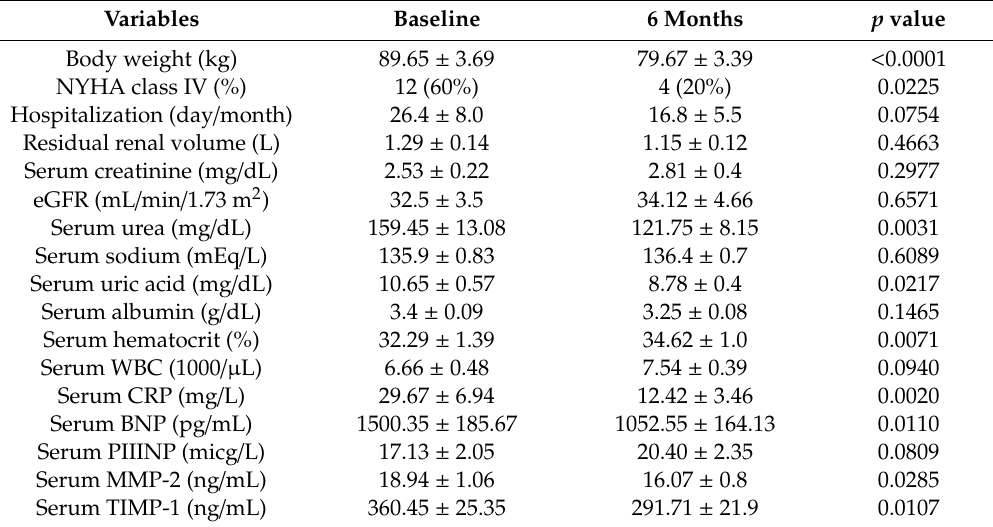
Table 3. Selected clinical and biochemical characteristics after 6 months of PD treatment ( n =